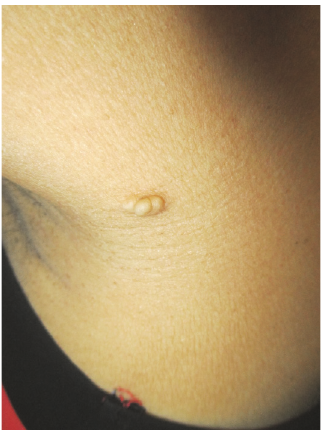
Figure 1: A soft, skin-colored, multilobulated, well-defined, dis- crete, dome-shaped plaque on the left lateral proximal arm adjacent to the axilla.